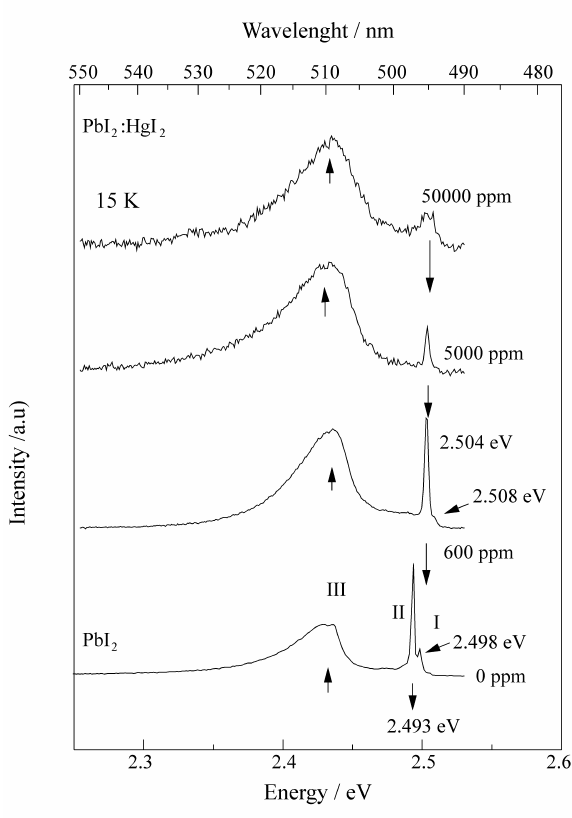
Figure 4. PL emissions near the band edge for PbI 2 and PbI 2 :HgI 2